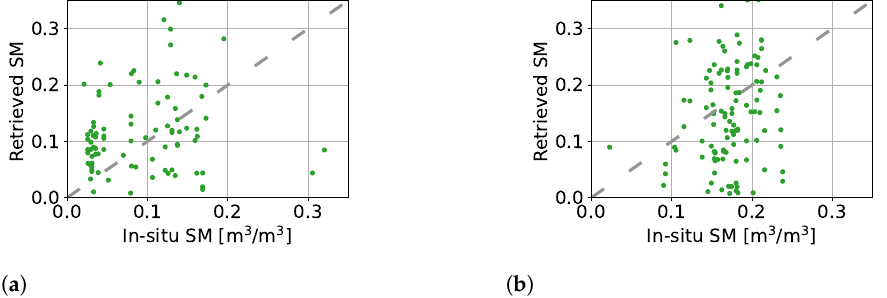
Figure 17. Soil moisture retrieval using the second scheme from DDMs close to Y8, Yanco site, compared to in situ measurements of Y8 station only. SM denotes soil moisture. ( a ) Year 2019.